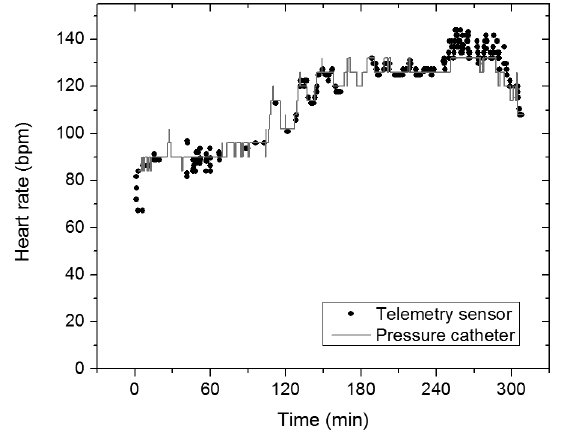
Figure 4. Heart rate measurements. Data from the arterial pressure catheter (grey) and the telemetry sensor (black).